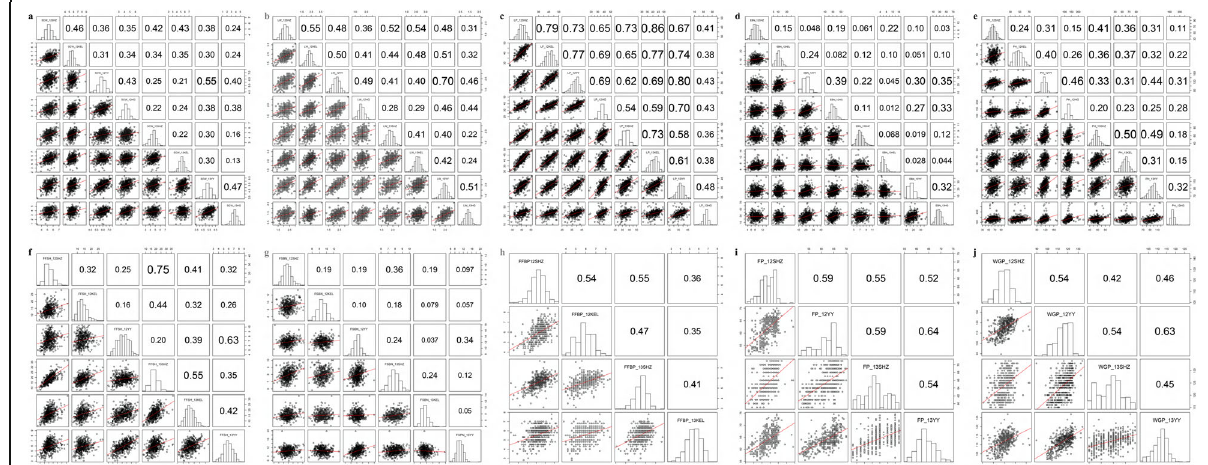
Fig. 2 The correlations of ten yield-related traits in multiple environments. a Correlations of SCW in eight environments. b Correlations of LW in eight environments. c Correlations of LP in eight environments. d Correlations of EBN in eight environments. e Correlations of PH in eight environments. f Correlations of FFSH in six environments. g Correlations of FSBN in six environments. h Correlations of FSBP in four environments. i Correlations of FP in four environments. j Correlations of WGP in four